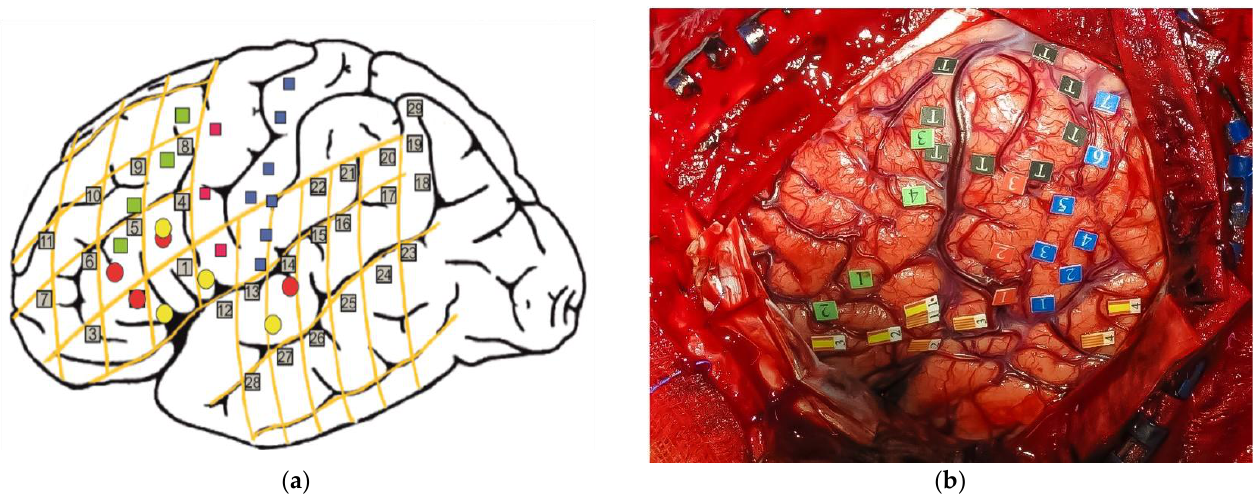
Figure 2. ( a ) Schematic picture representing where involuntary language switching (green), motor response (red), and sensory response (blue) were elicited by direct cortical stimulation. Essential areas for both languages are represented by red (Spanish) and yellow colors (Catalan). ( b ) A photograph was taken during surgery after the completion of ESM in the same patient. The area enclosed by flags with the letter T represents where the tumor was located. Image from the LS-patient series from Sierpowska and Fernandez-Coello (2018) [92].